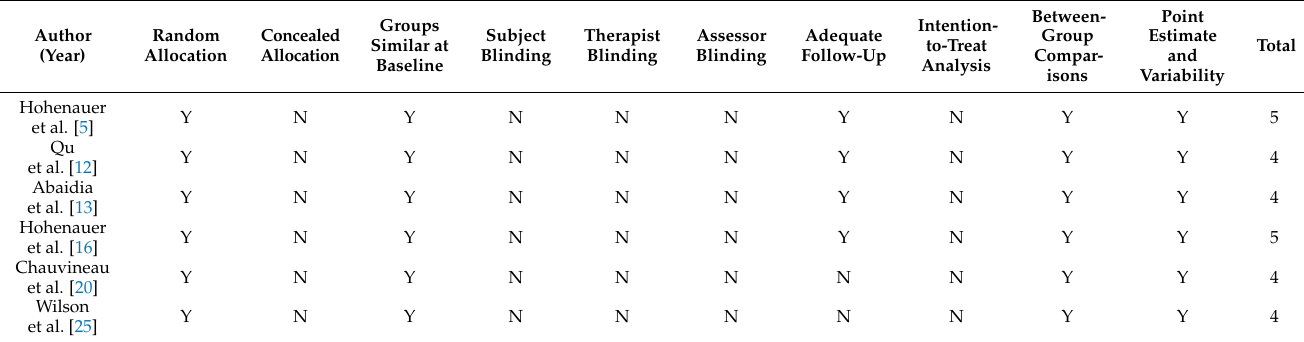
Table 1: PEDro scale score of included studies in metanalysis.